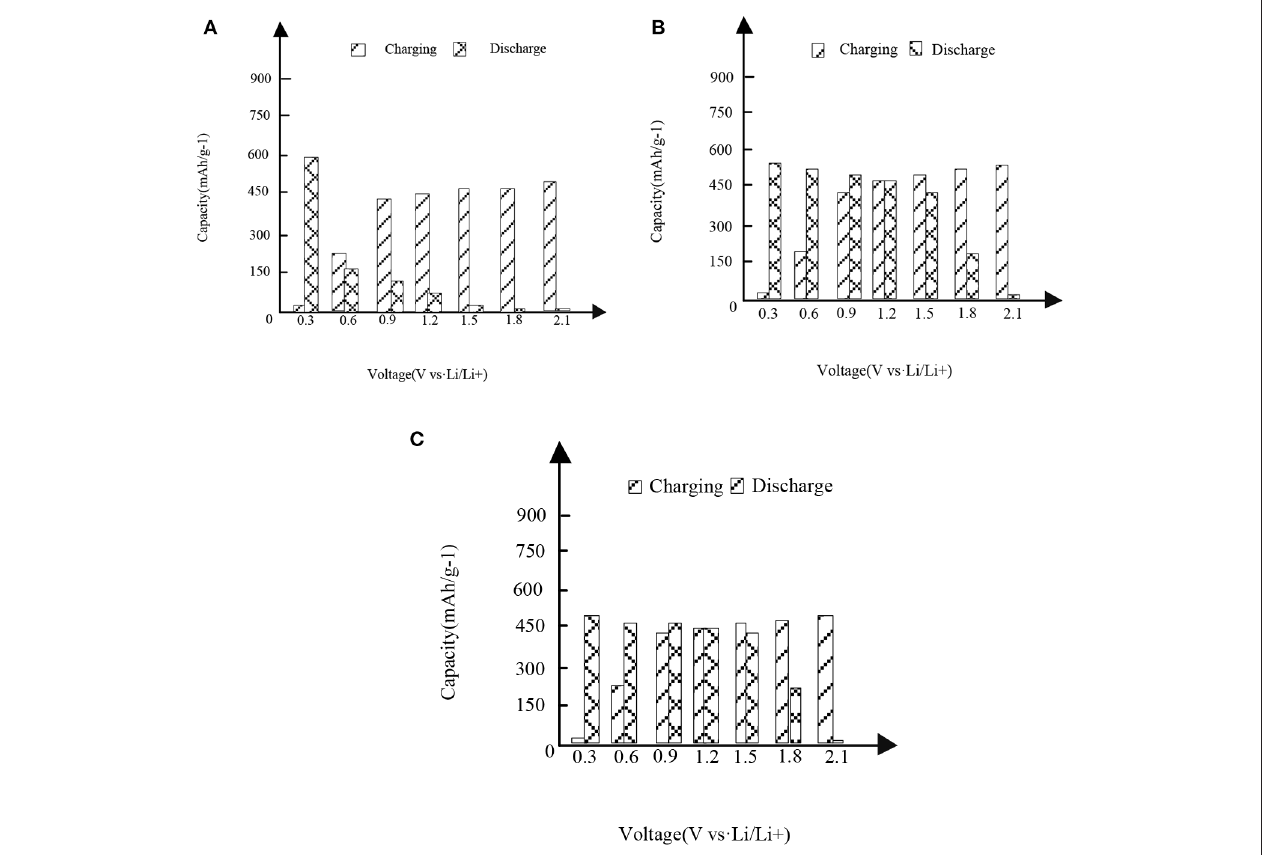
FIGURE 4 | The first three charges and discharges of the new high entropy alloy material and FeSn2 material at the current density of 50 mAg − 1 . (A) First charge and discharge. (B) Second charge and discharge. (C) Third charge and